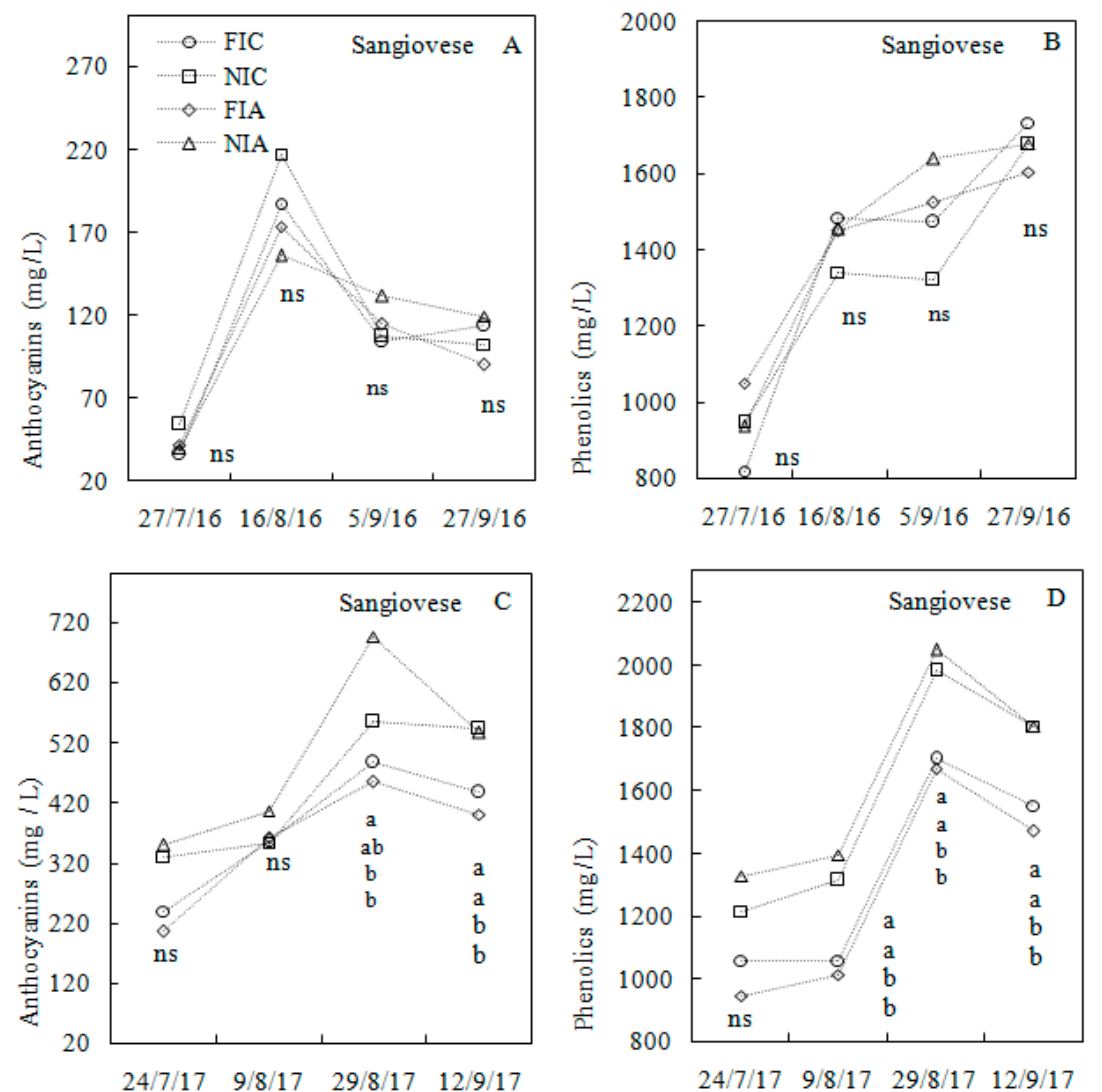
Figure 5. Seasonal variations of grape total anthocyanins in 2016 ( A ) and 2017 ( C ) and phenolics in 2016 ( B ) and 2017 ( D ) in cv. ‘Sangiovese’. FIA = full irrigation ( + ) ABA; FIC = full irrigation ( − ) ABA; NIA = no irrigation ( + ) ABA NIC = no irrigation ( − ) ABA. The di ff erent letters indicate statistical significance at P ≤ 0.05 using the LSD test. Ns = not significant.